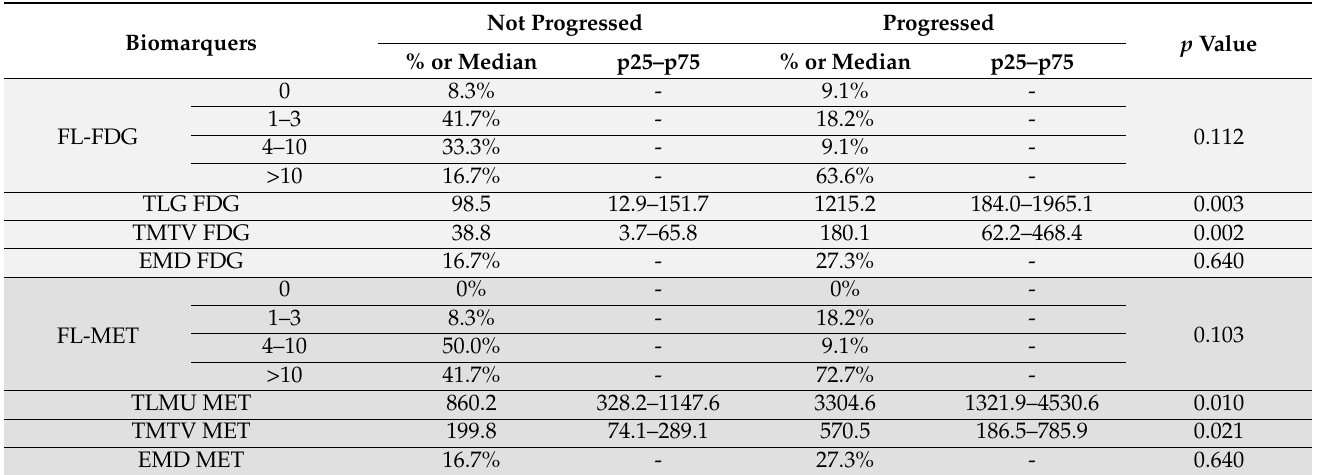
Table 5. Baseline FDG and MET parameters in relapsed patients according to clinical outcome (progression).